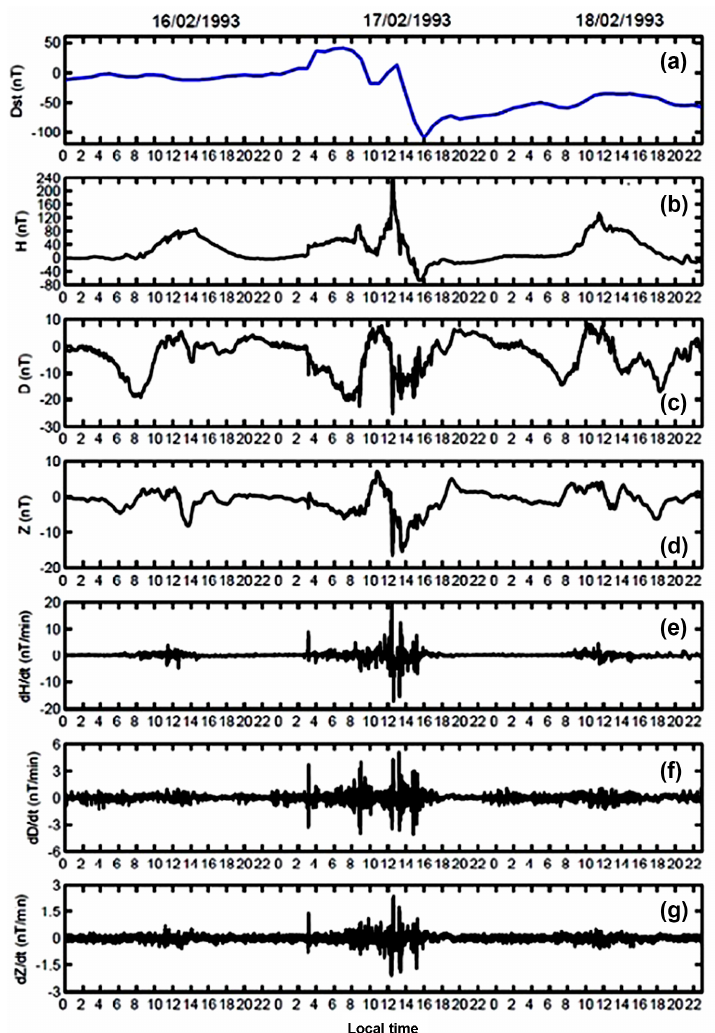
Figure 3. Dst index (a) , variations in H (b) , D (c) and Z (d) components, and the time derivatives d H/ d t (e) , d D/ d t (f) and d Z/ d t (g) on 16–18 February 1993 at SIK (0.12 ◦ dip